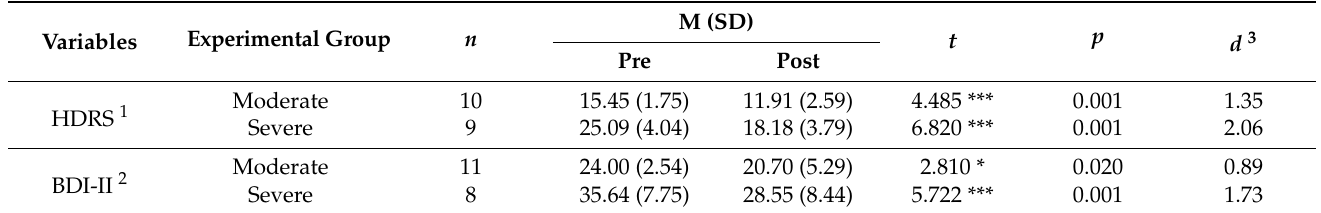
Table 3. Comparison of measurements between pre- and post-test within the moderate and severe MDD